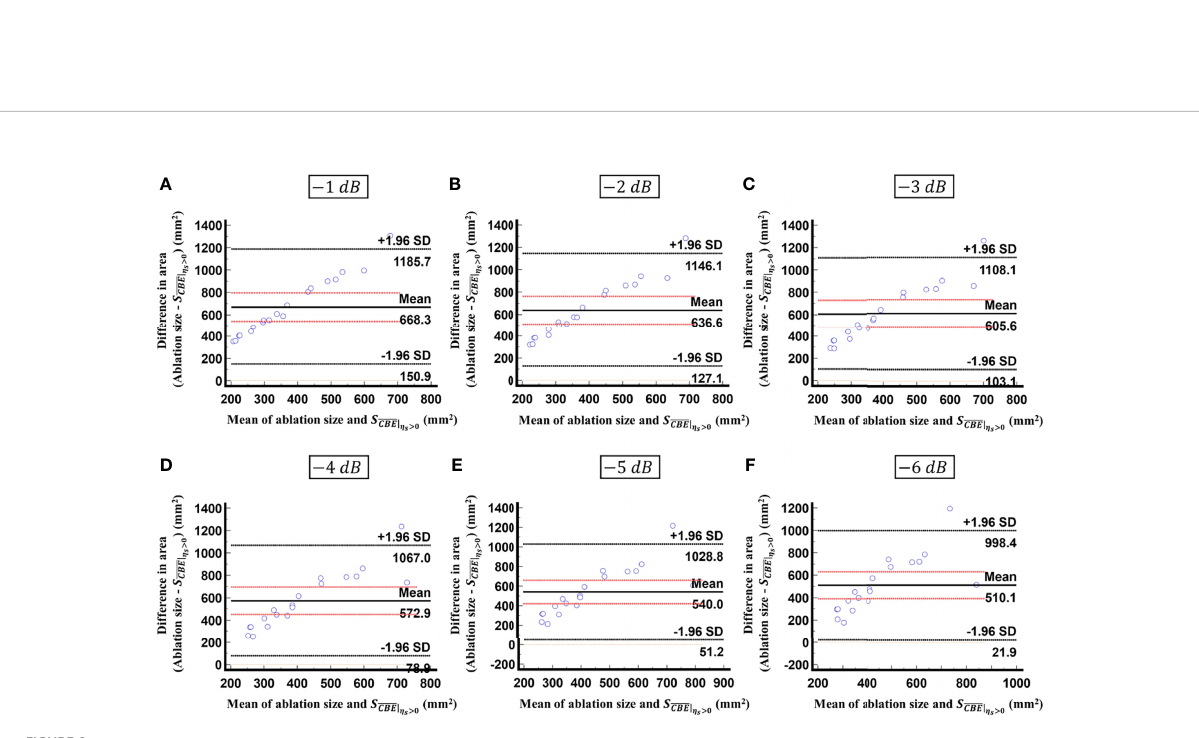
FIGURE 9 Bland-Altman plots of the differences between the ablation zone sizes and S CBE j values against the averages of the two sets of measurements h s> 0 obtained according to various contour criteria. (A) − 1 dB; (B) − 2 dB; (C) − 3 dB; (D) − 4 dB; (E) − 5 dB; (F) − 6 dB. The red lines represent the 95% CI of the mean difference. The black lines mean the limits of agreement. In comparison with the results in Figure 8 , less than 30% of the data fi tted into is inappropriate for estimating the ablation zone the 95% CI, indicating that S CBE j h s> 0